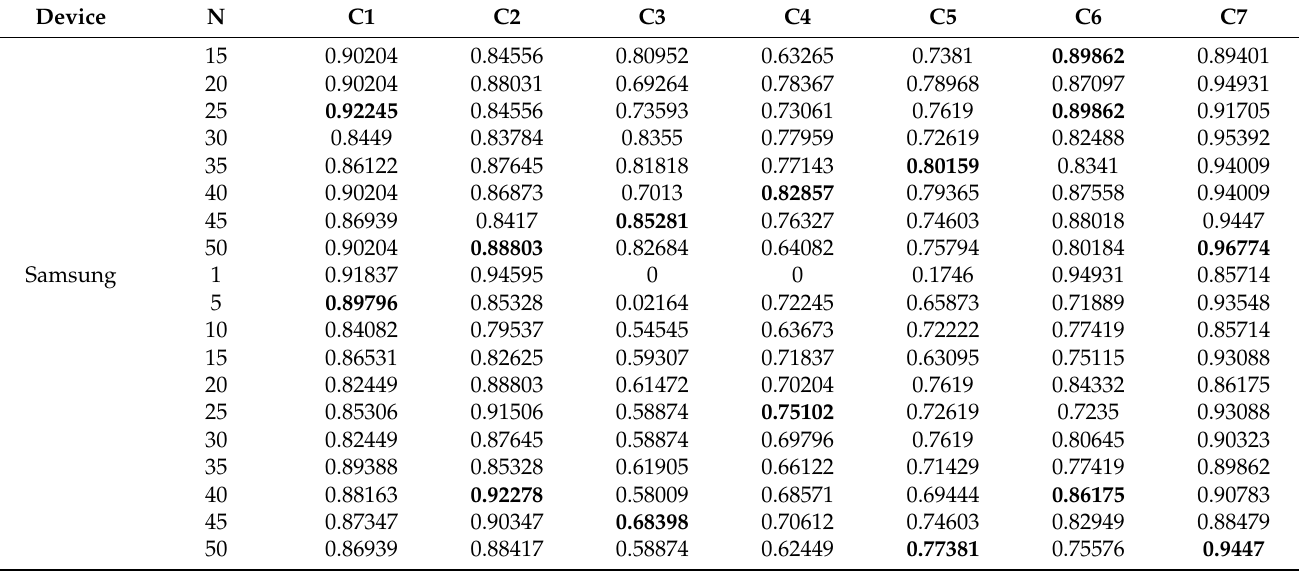
Table 6. Results of the estimation of the value and chroma.